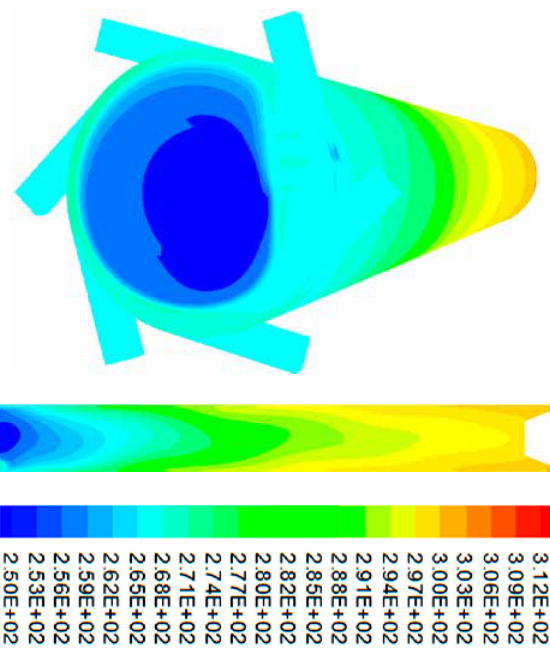
Fig. 18. Temperature distribution inside the vortex tube operating with compressed air, a = 0.3, using the RSM